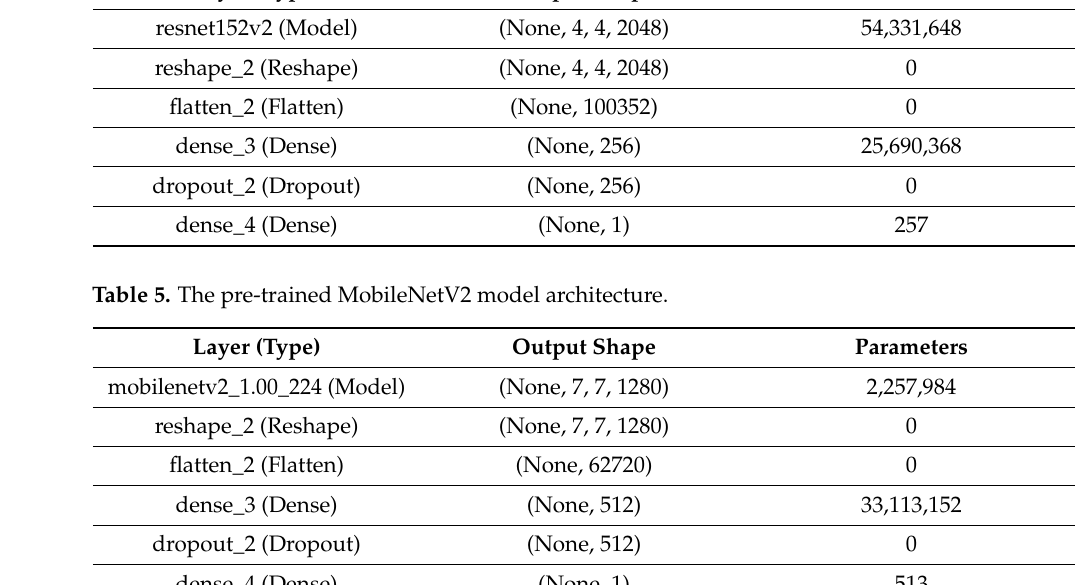
Table 4. The pre-trained ResNet152V2 model architecture.